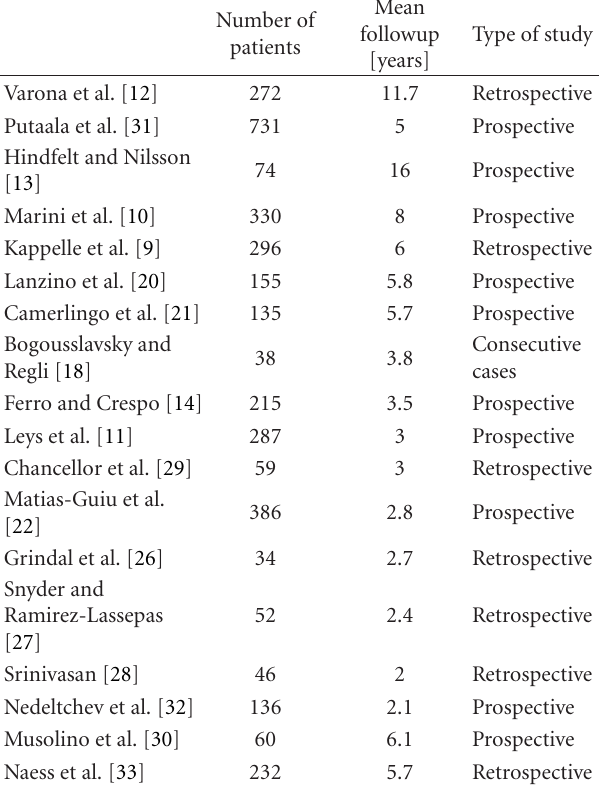
Table 1: Long-term followup series in young adults with ischemic stroke.